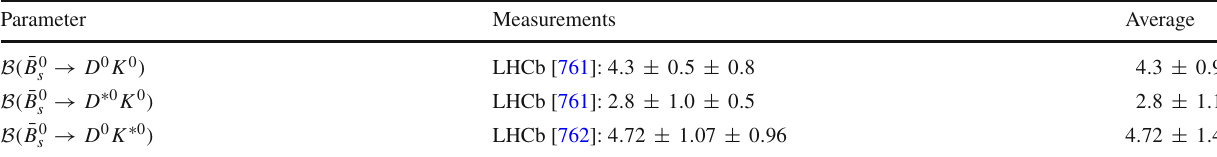
Table 188 Decays to a D ( ∗ ) and a light meson I [ 10 − 4 ]